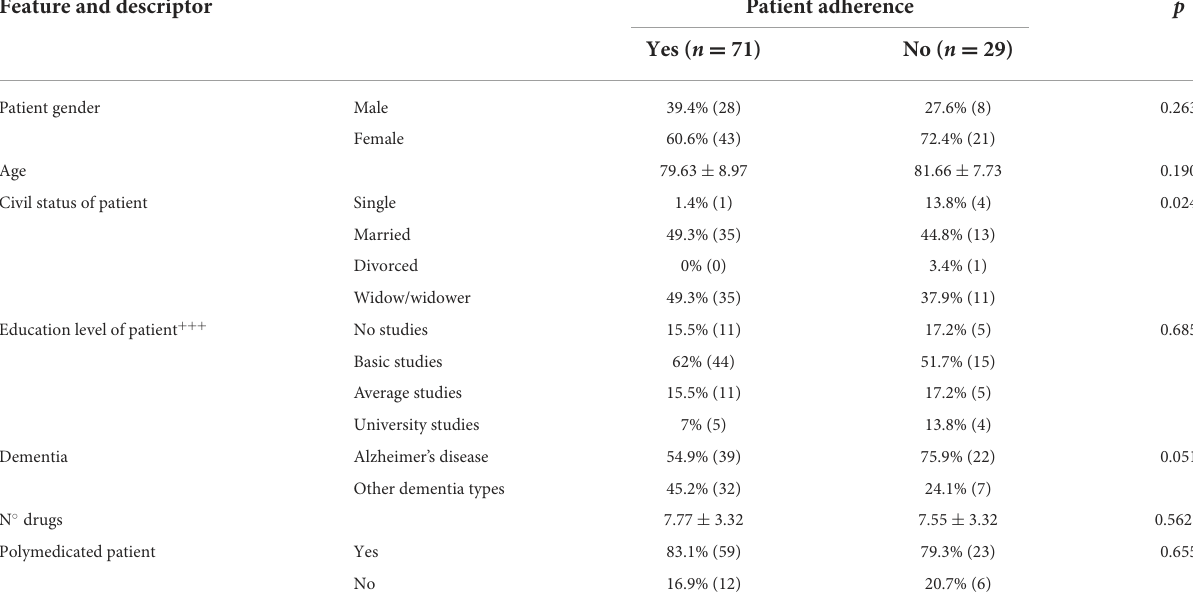
TABLE 1 Prevalence of the adherence and non-adherence groups according to the results of the Morisky-Green-Levine test related to the sociodemographic factors of the patients ++ . Feature and descriptor